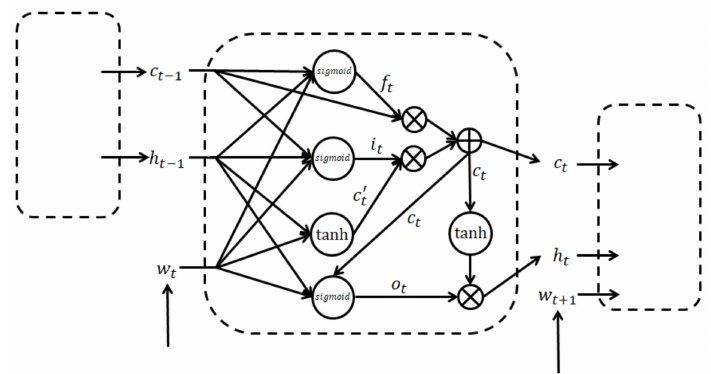
Figure 2. LSTM unit